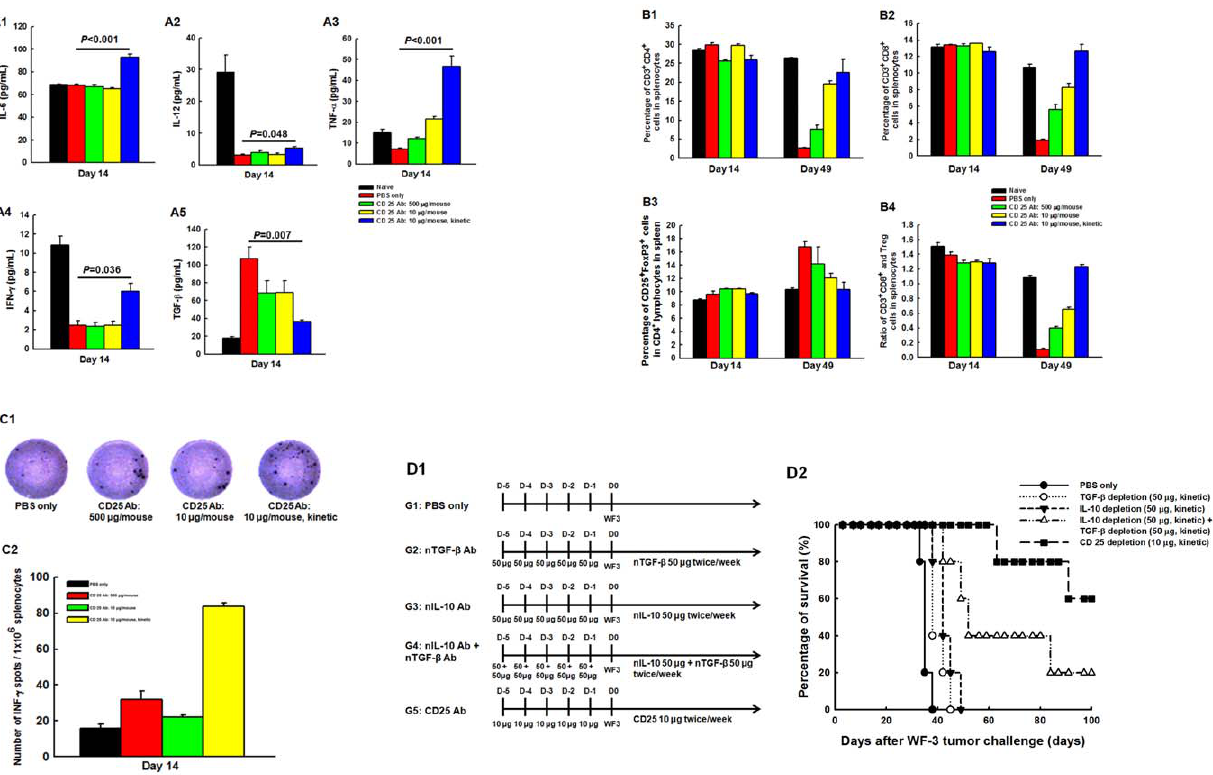
Figure 6. The concentrations of cytokine profiles in ascites and kinetic changes of various lymphocytes in splenocytes of WF-3- challenged mice treated with PBS or CD25 monoclonal antibody. ( A ) Concentrations of various cytokines in ascites. A1, IL-6; A2, IL-12; A3, TNF- a ; A4, IFN- c ; A5, TGF- b . Note : Compared to mice treated with PBS only, the concentrations of cytokines like IL-6, IL-12, TNF- a , and IFN- c were significantly elevated in mice treated with kinetic low-dose CD25 antibody than those in the other groups. The concentrations of TGF- b significantly decreased in the kinetic low-dose CD25 Ab group compared to the other groups. ( B ) Percentages of various lymphocytes. B1, CD3 + CD4 + help T lymphocytes. Note : The percentages of CD4 + T lymphocytes in the splenocytes were not different between the PBS and CD25 Ab depletion groups on day 14 after WF-3 tumor challenge. However, the kinetic low-dose CD25 Ab depletion group had higher percentages of CD4 + helper T cells than the PBS and the other two sequential CD25 Ab depletion groups after 49 days of tumor challenge. B2, CD3 + CD8 + cytotoxic T lymphocytes. Note : The percentages of CD8 + T cells were not different between the PBS and CD25 Ab depletion groups on 14 days after tumor challenge. The kinetic low- dose CD25 Ab depletion group had higher percentages of CD8 + cytotoxic T cells than the other groups on day 49 after tumor challenge. B3, CD4 + CD25 + Foxp3 + Treg cells. Note : The percentages of Treg cells in the splenocytes were not different among these groups on day 14 after tumor challenge. However, the kinetic low-dose CD25 Ab depletion group had lower percentages of Treg cells than the other groups on day 49. B4, ratios of cytotoxic T lymphocytes/Treg cells. Note : The ratios of CD8 + cytotoxic T cells/Treg cells in the kinetic low-dose CD25 Ab depletion group were highest among the four groups. ( C ) Mesothelin-specific IFN- c ELISPOT assays of splenocytes in the PBS and CD25 Ab-treated groups. C1, the representative figures of mesothelin-specific IFN- c ELISPOT assays of splenocytes; C2, bar figures of the numbers of IFN- c -secreting, mesothelin-specific T lymphocytes in various groups. Note: The kinetic low-dose CD25 Ab depletion group generated the highest numbers of IFN- c -secreting, mesothelin- specific T lymphocytes compared to the other groups. ( D ) Survivals of mice treated with PBS, neutralizing TGF- b , neutralizing IL-10 or CD25 monoclonal antibodies. D1, Diagrammatic representation of the different treatment protocols of neutralizing TGF- b , neutralizing IL-10 or CD25 monoclonal antibody; D2, Survival curves of mice treated with PBS, neutralizing TGF- b , neutralizing IL-10, neutralizing TGF- b and neutralizing IL-10 or CD25 monoclonal antibody. Note: The mice treated with kinetic low-dose CD25 Ab had the longest survival time after WF-3 tumor challenge when compared to the other mice treated with PBS, neutralizing TGF- b , neutralizing IL-10 or neutralizing TGF- b and neutralizing IL-10 monoclonal